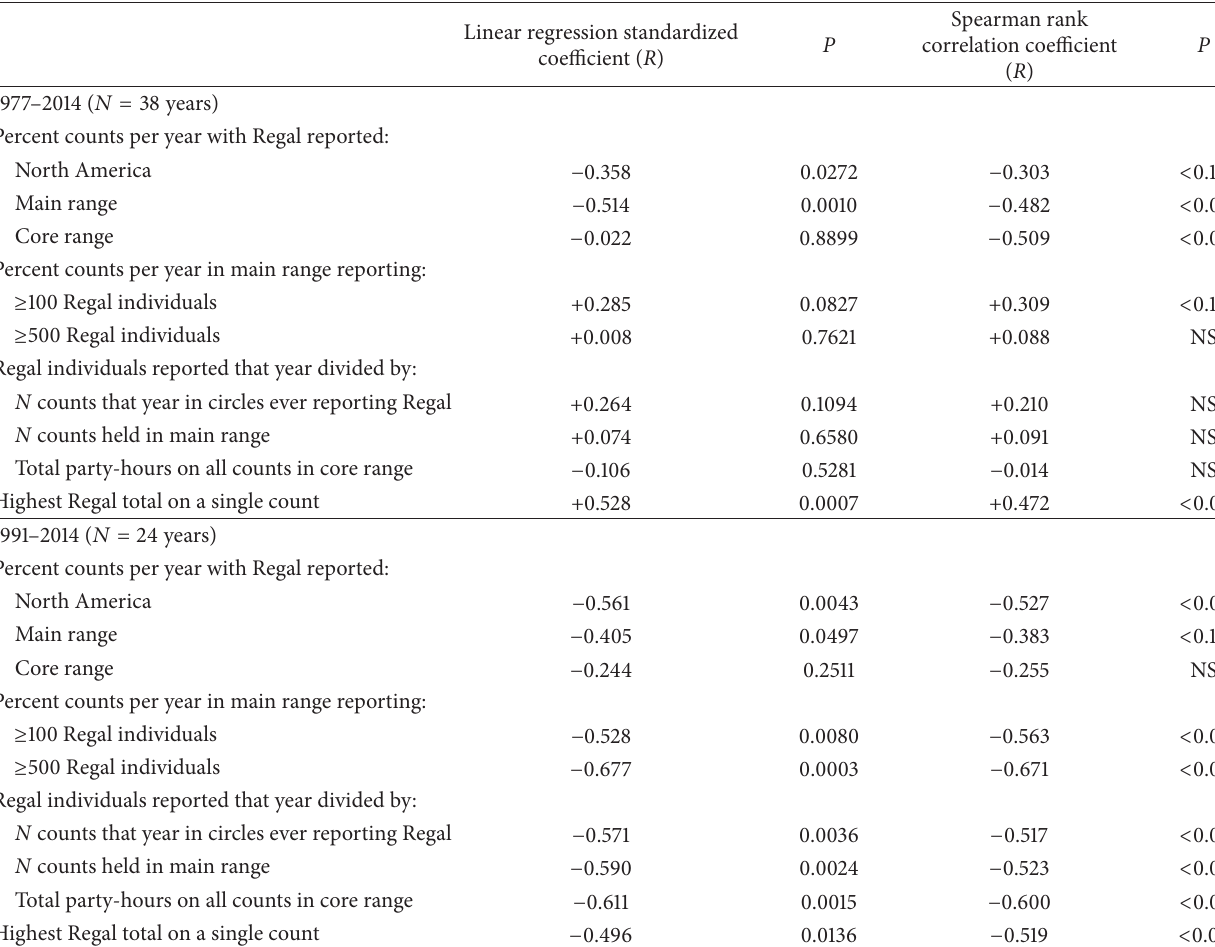
Table 3: Results of linear regressions and Spearman rank correlations of dependent variables versus year. NS = not significant.